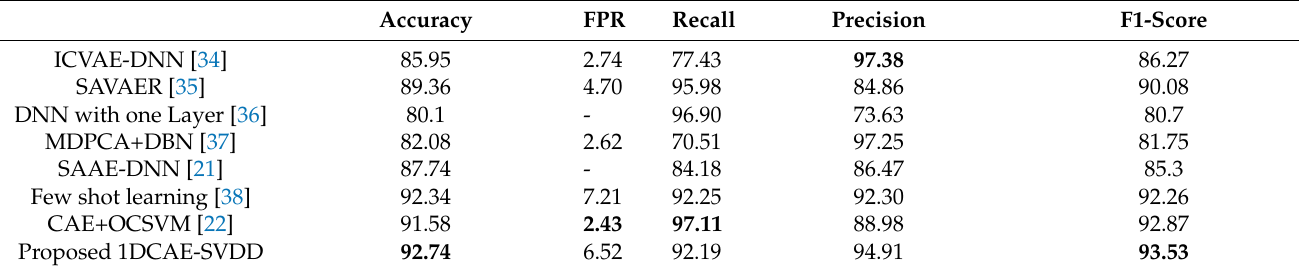
Table 7. Comparative analysis with some state-of-art methods on